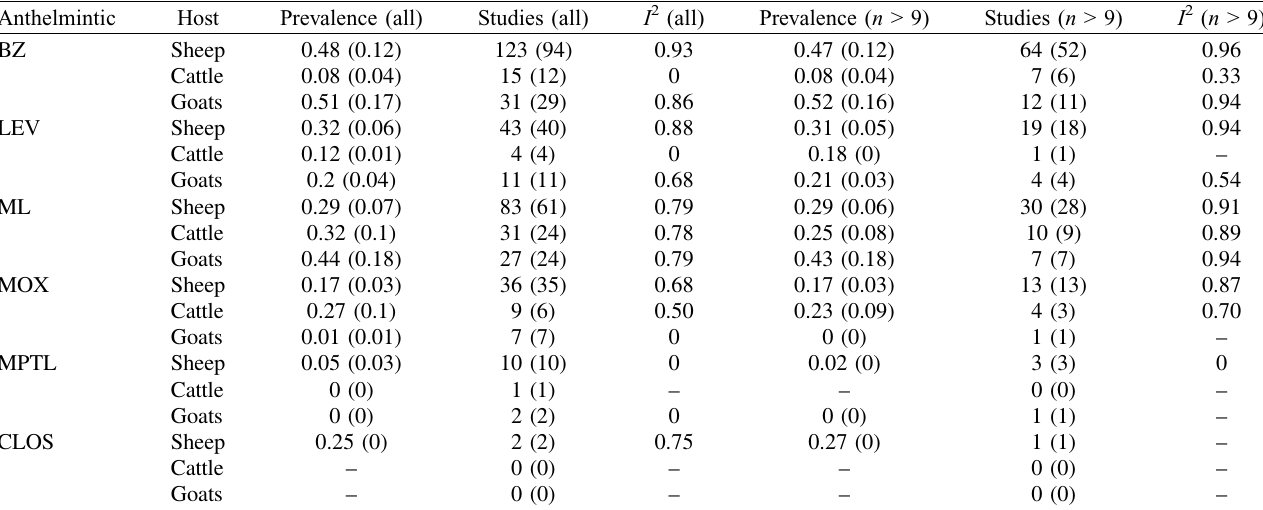
Table 1. Mean (SD in parenthesis) sample size-weighted prevalence of anthelmintic resistance strati fi ed by anthelmintic class and host